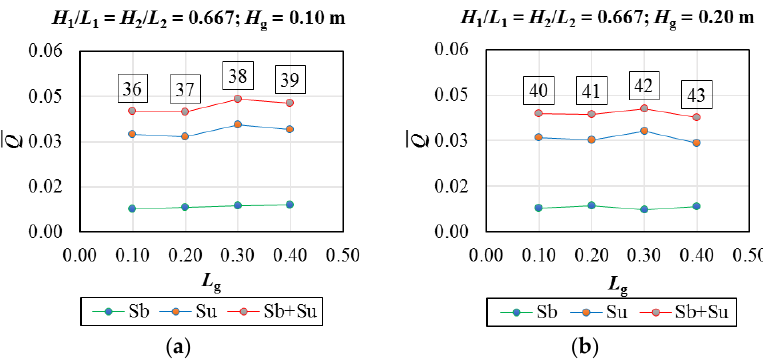
Figure 21. Behavior of Q ̅ × L g for: ( a ) cases 28, 29, 30 and 31 and ( b ) 32, 33, 34 and 35.